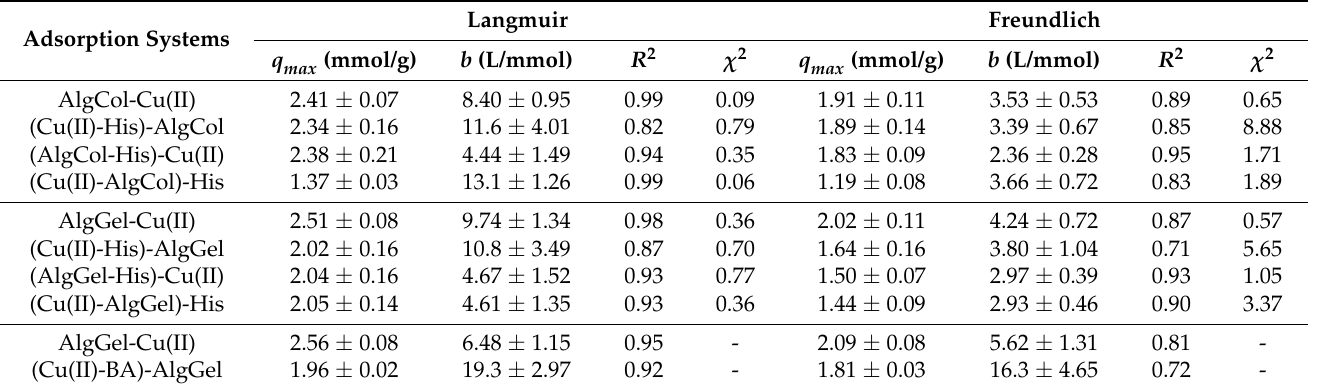
Table 3. Isotherm parameters for the Langmuir and Freundlich models. Parameters were retrieved by inputting the data for copper ion adsorption in AlgCol and AlgGel